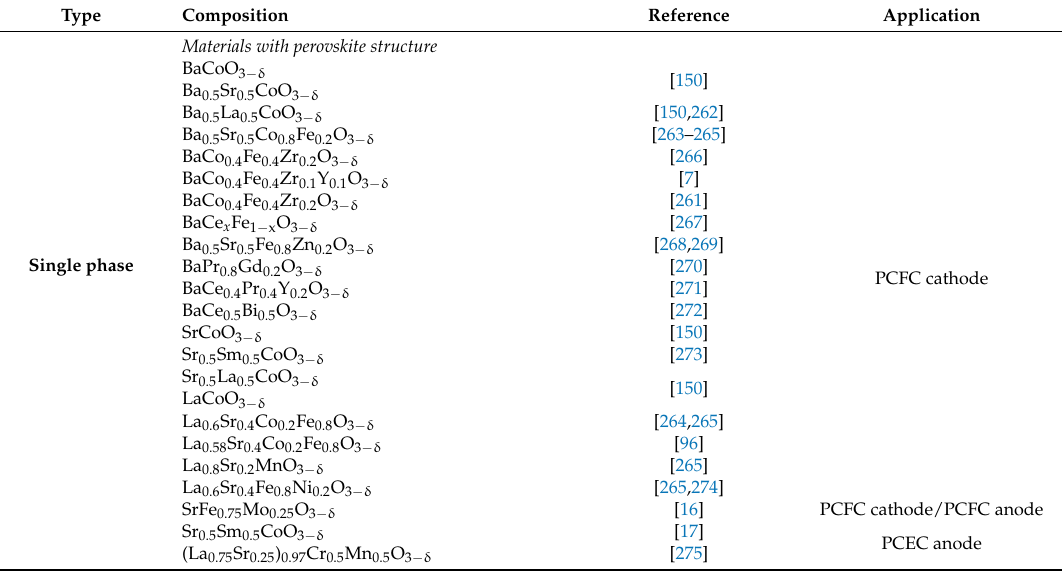
Table 7. List of materials used as electrodes in electrochemical cells based on proton conducting